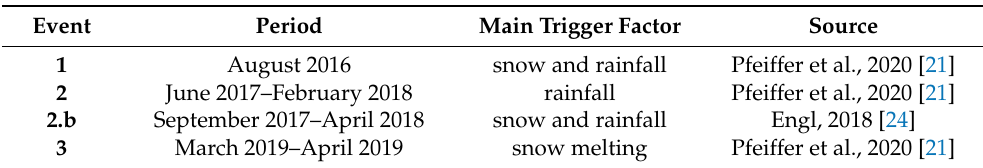
Table 1. Summary of the main acceleration events over Vögelsberg rockslide in the period 2016–2019 according to